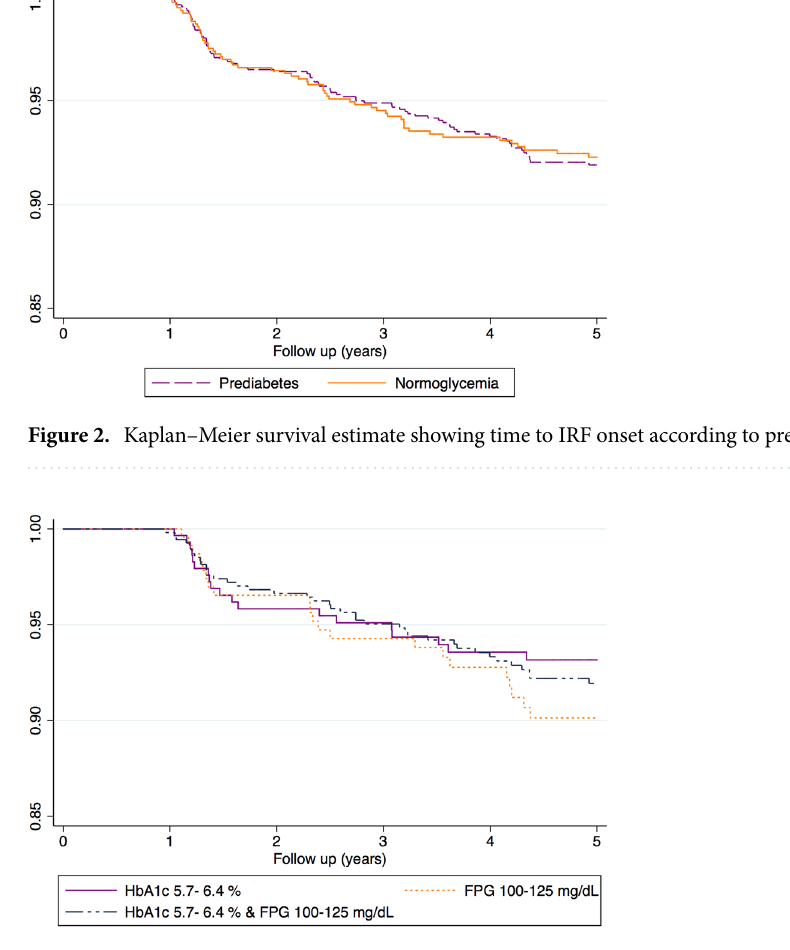
Figure 3. Kaplan–Meier survival estimate showing time to IRF onset according to type of